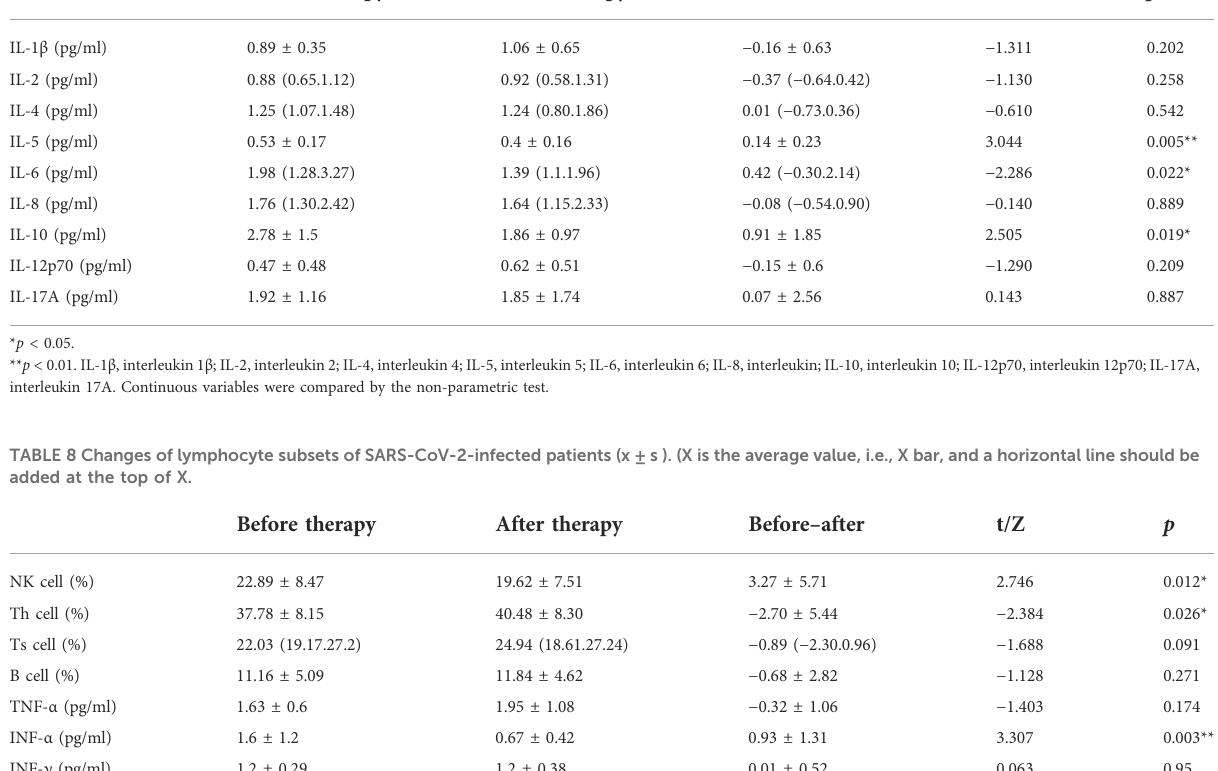
TABLE 7 Changes of in fl ammatory factors of SARS-CoV-2-infected patients. Before therapy After therapy Before – after t/Z p value